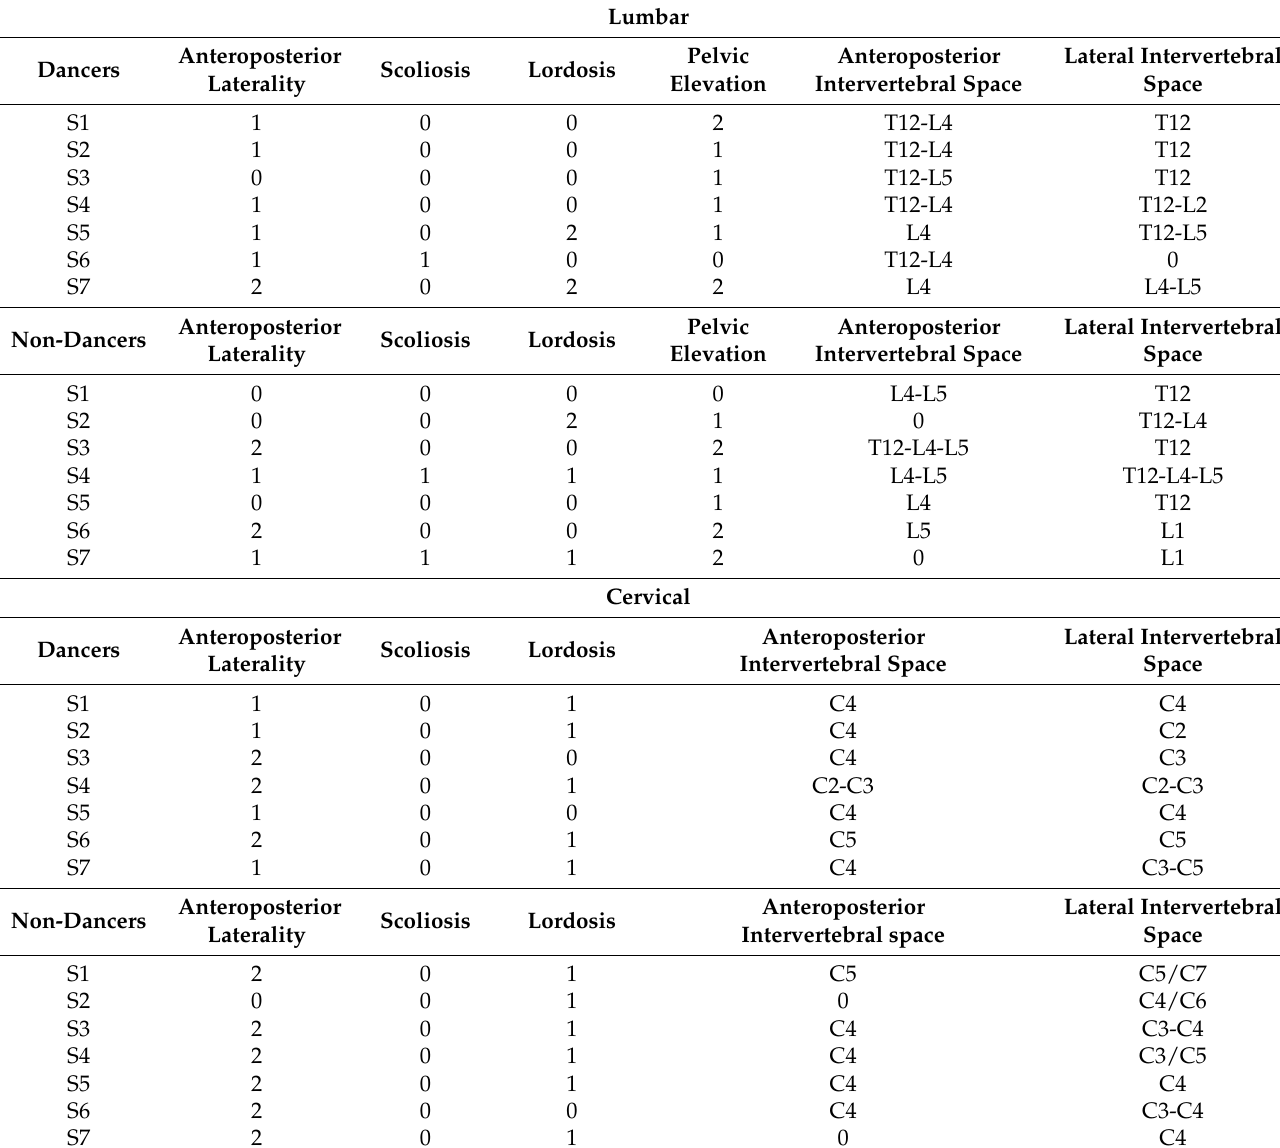
Table A1. Radiologic characteristics of dancers and